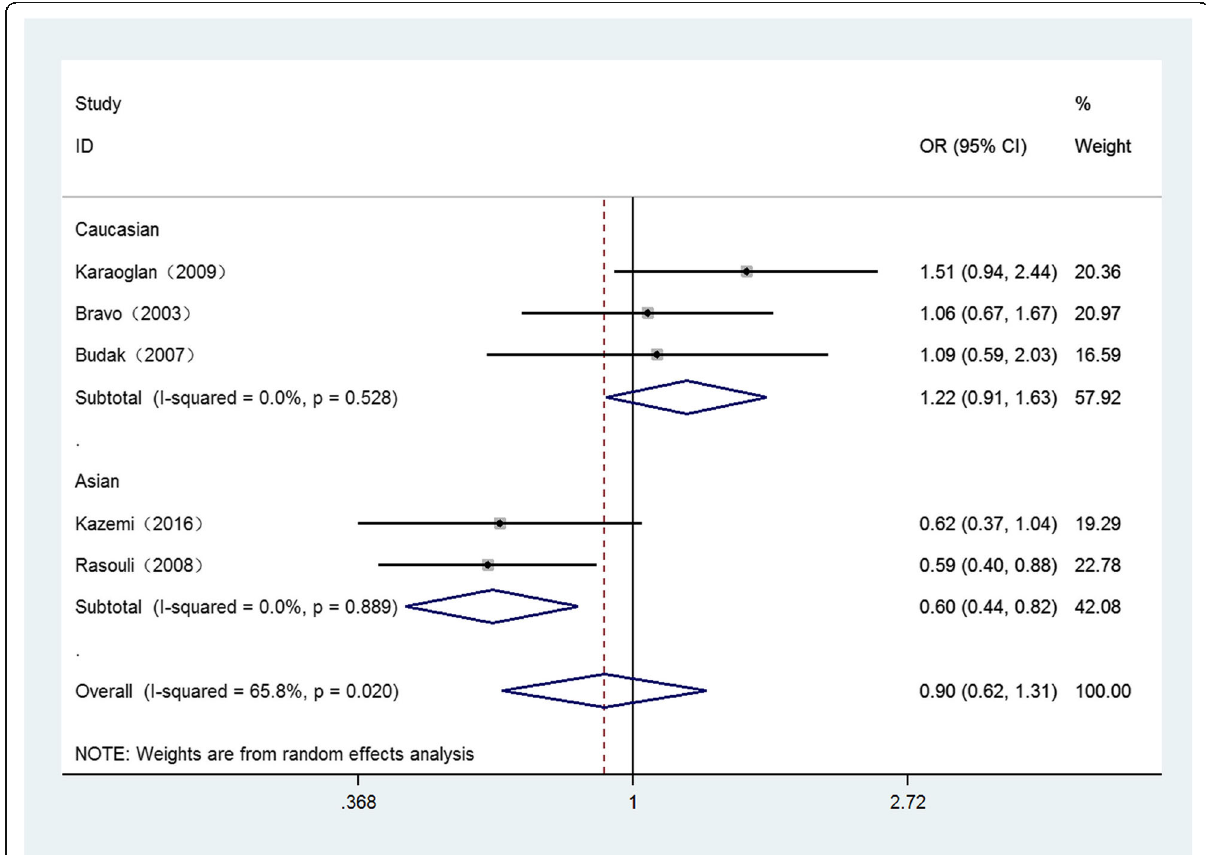
Fig. 2 Forest plot of IL-10 -819 C/T polymorphism on Brucellosis risk in allele model (T vs.